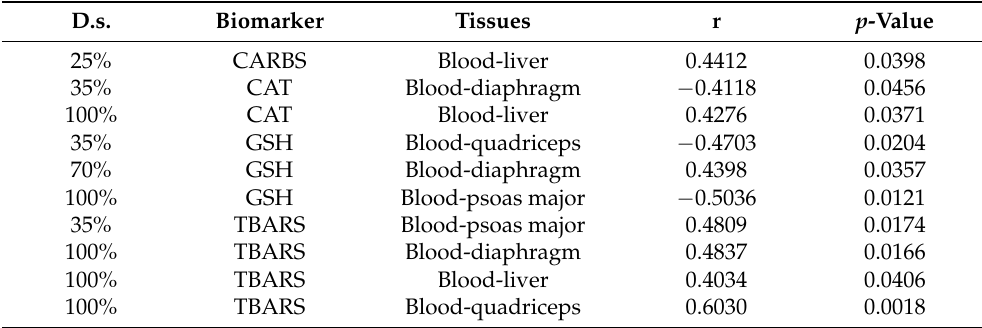
Table 2. Linear regression analysis between redox biomarker levels in lambs’ blood and the other 4 tissues tested (liver, diaphragm, quadriceps, psoas major) at the same d.s. ( p < 0.05, r >